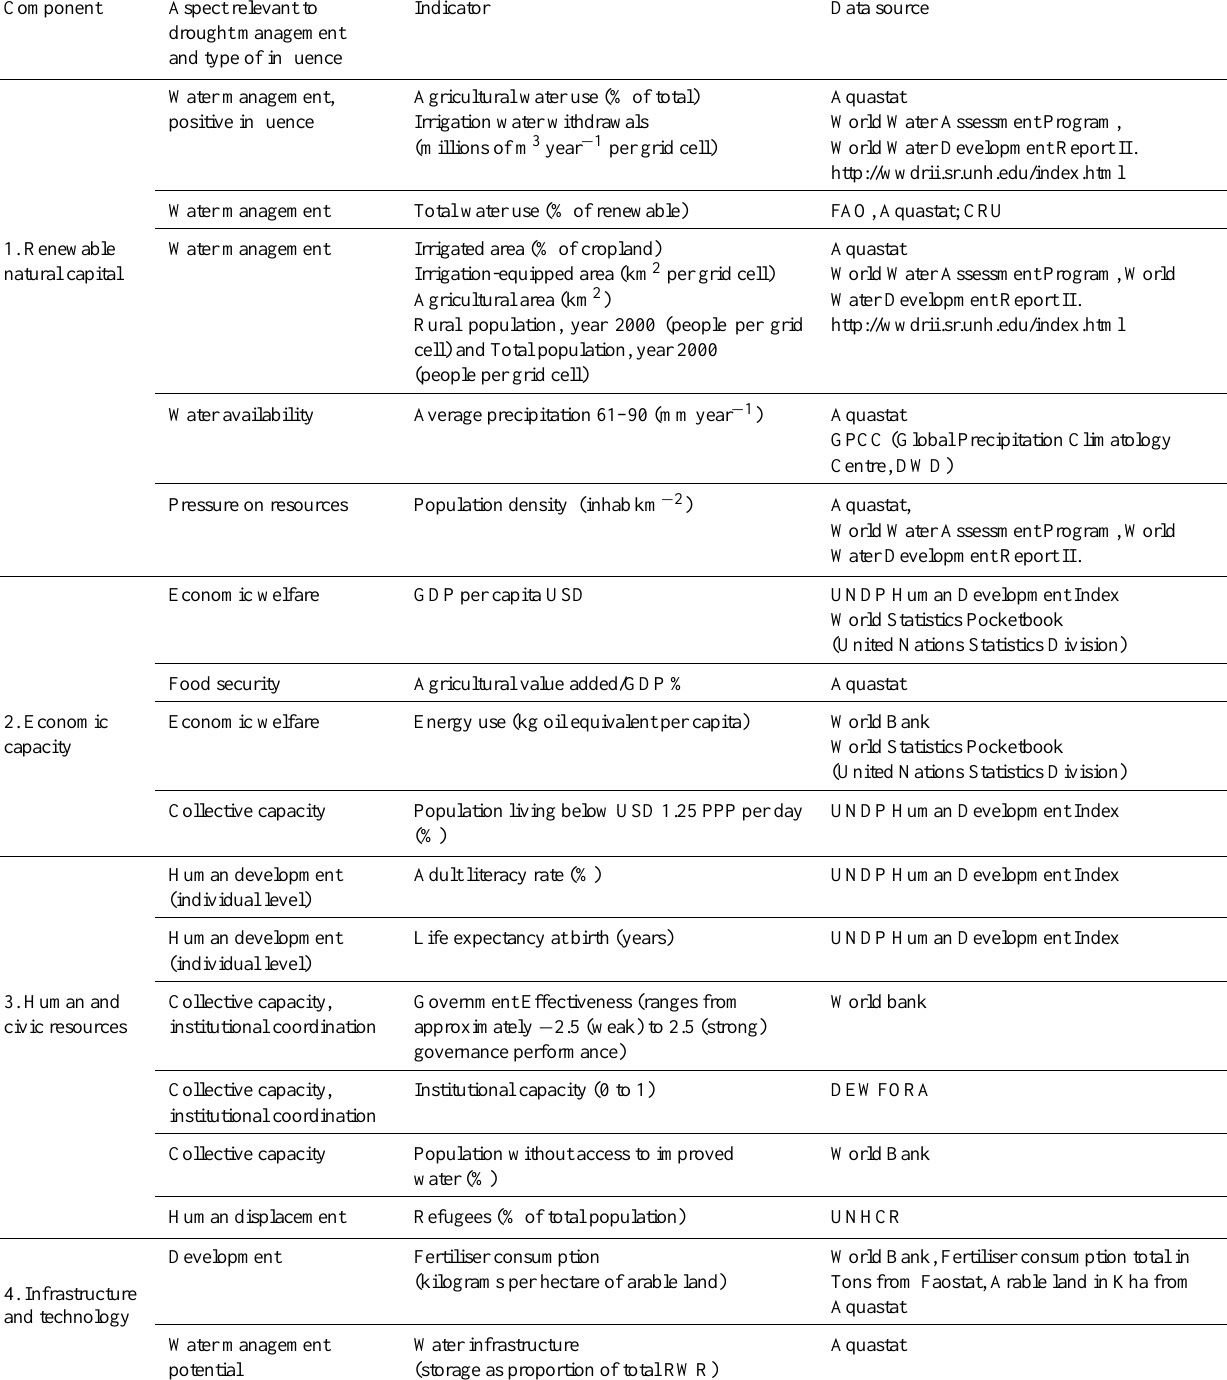
Table 1. Vulnerability factors and their related weights included in the DVI.